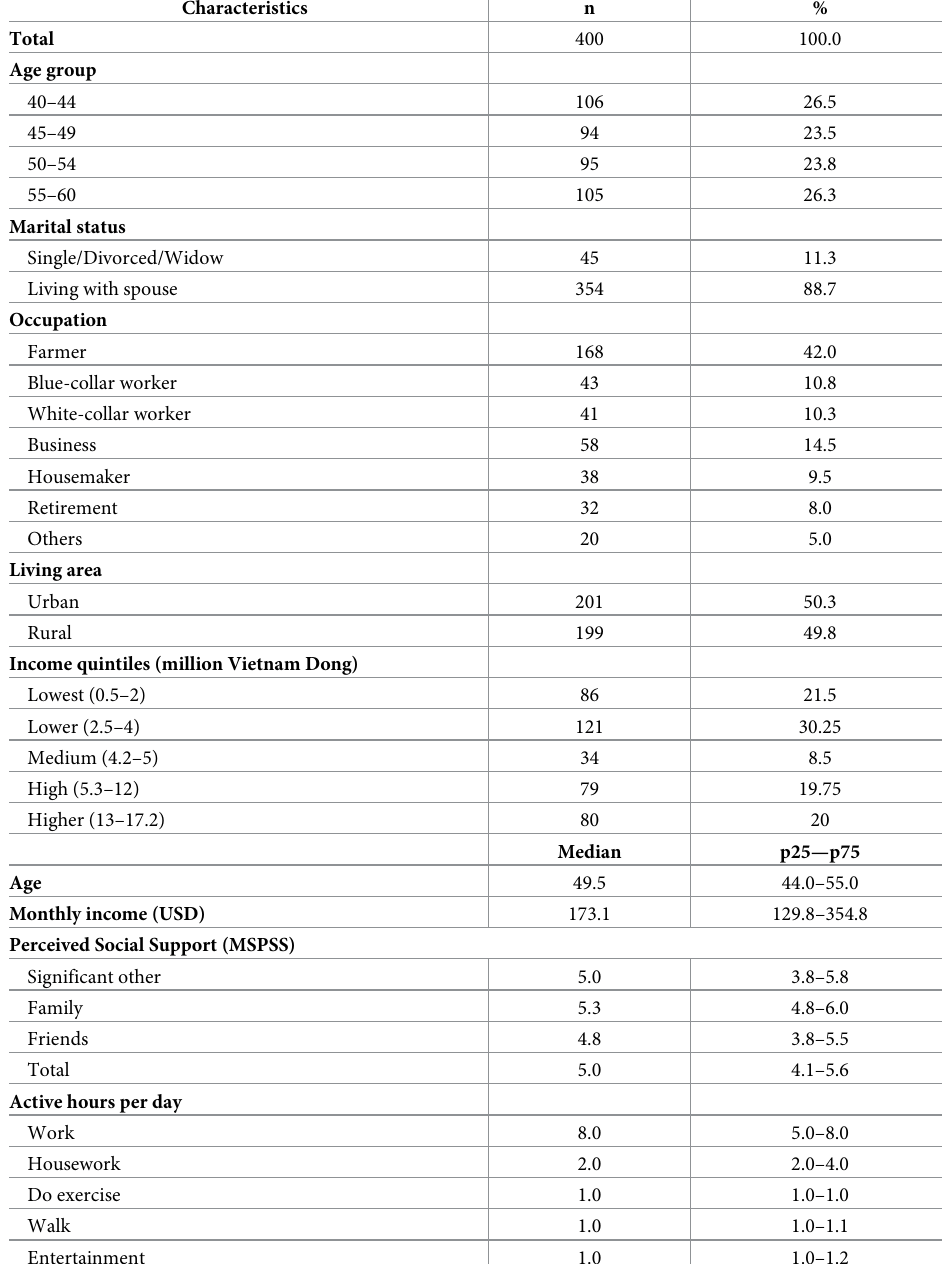
Table 1. Characteristics of